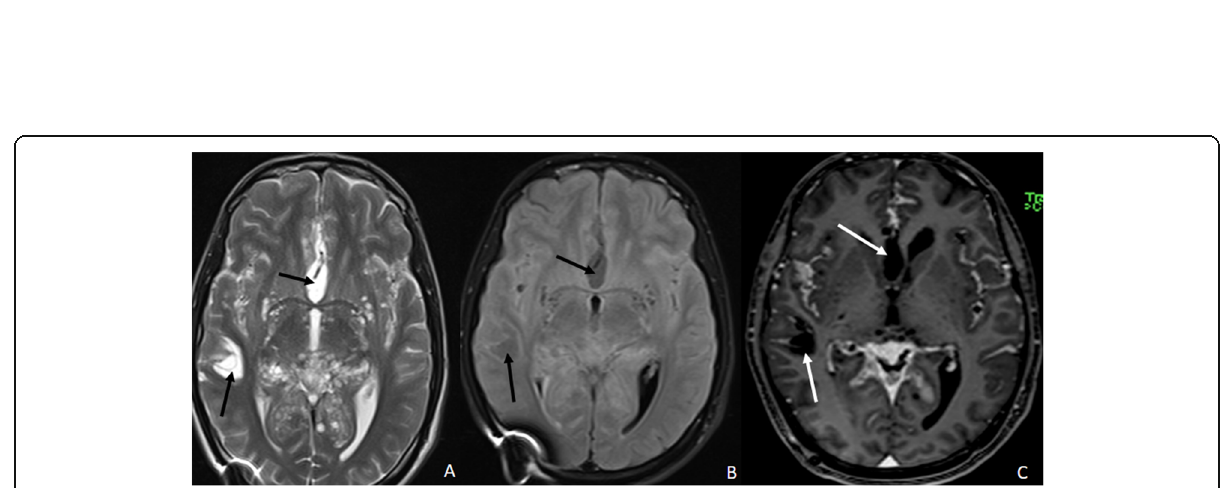
Fig. 5 Follow-up magnetic resonance imaging of the brain at our institute 8 months after the onset of the symptoms. A T2W axial image of the brain at the level of the basal ganglia shows T2 hyperintense cystic structures in the right temporal operculum and the anterior interhemispheric fissure as pointed out with the help of black arrows. B Axial FLAIR image of the brain at the level of the basal ganglia shows the signal suppression in the cystic lesions on FLAIR as compared with T2W image shown in A . This finding is pointed out with the black arrows. C Post-contrast T1W axial image of the brain at the level of basal ganglia shows no evidence of enhancement of the cystic structures, pointed out with white arrows. These cystic structures may represent encysted or loculated